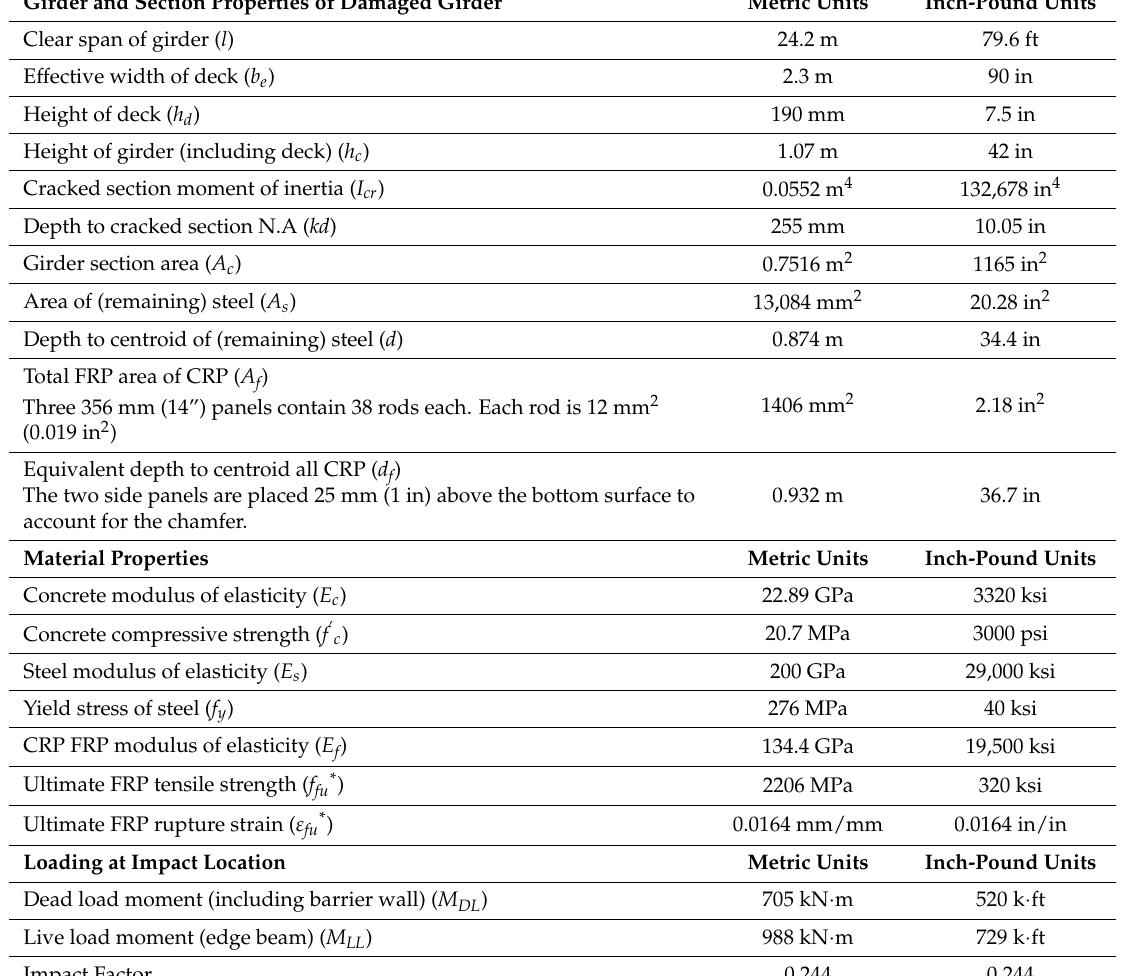
Table A1. CRP retrofit design